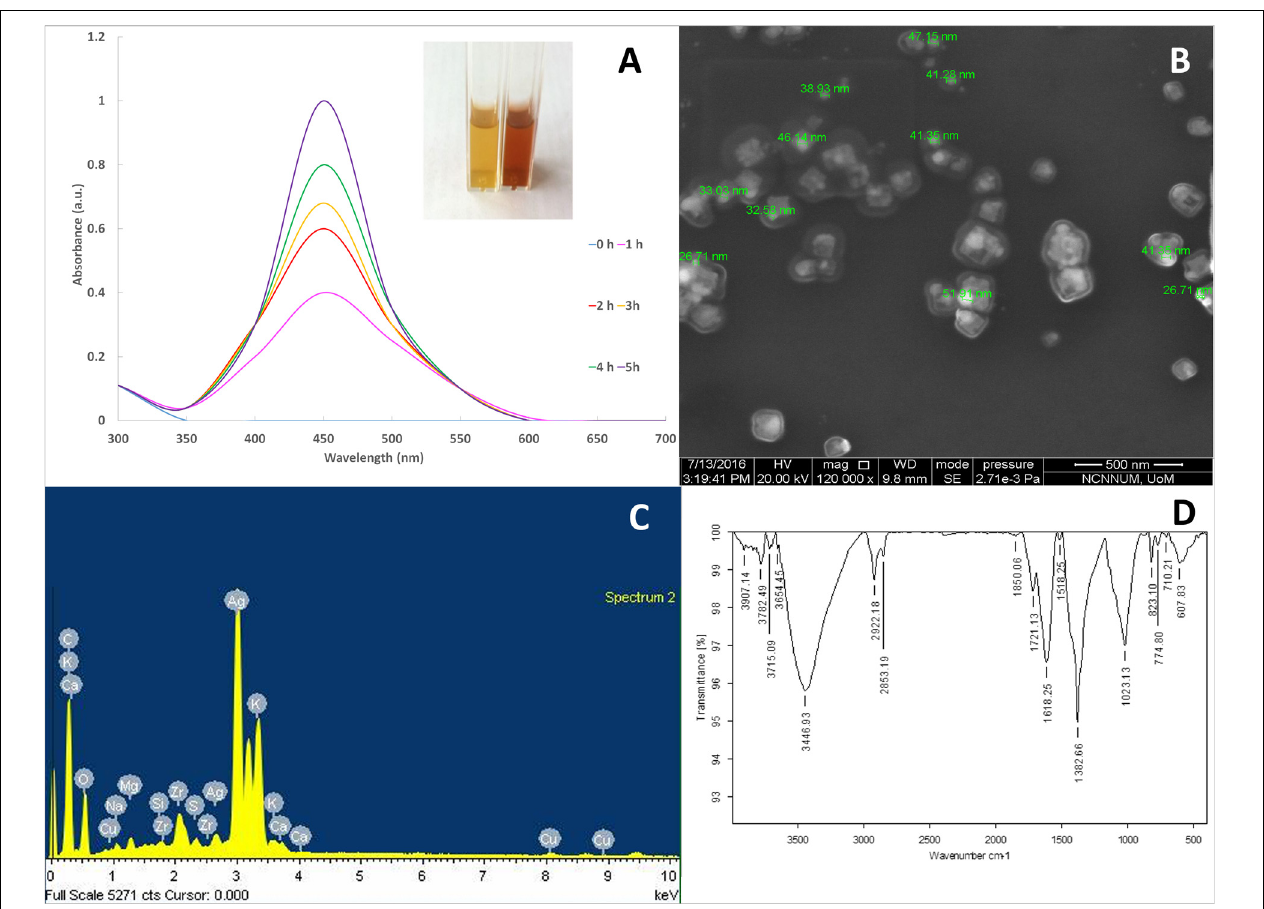
FIGURE 1 | (A) UV-Vis spectra of SNP synthesized using C. tamala extract; inset figure: color change from pale yellow (0 h) to dark brown (5 h) indicating synthesis of nanoparticles. (B) FEG-SEM of SNPs synthesized using C. tamala leaf extract depicting spherical nanoparticles. (C) Energy Dispersive X-ray spectrum of